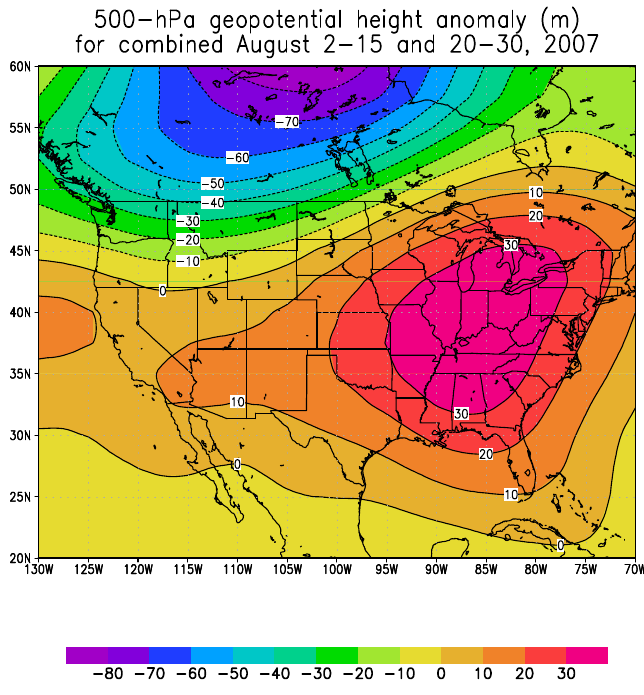
Figure 13. 500-mb geopotential height anomaly (in units of m) for the predefined sub-period of August 2007, accompanied with excellent wind resources in Callahan Divide Wind Energy